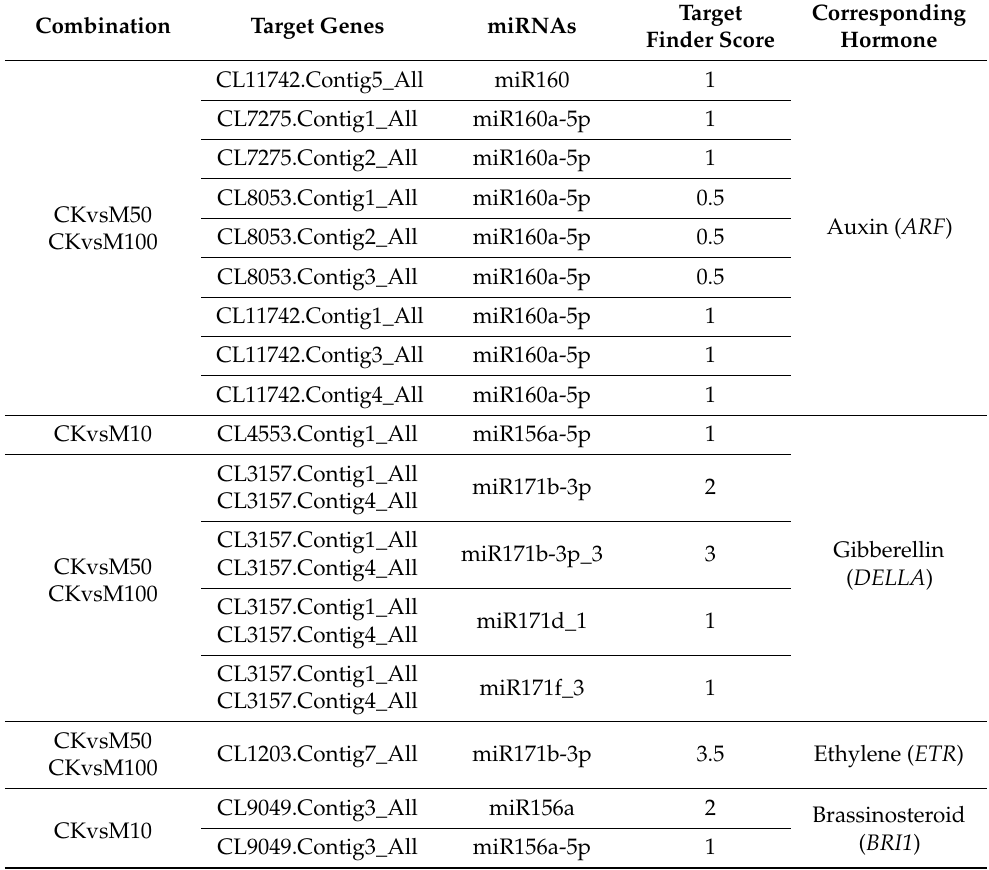
Table 1. miRNAs and target genes related to plant hormone signal transduction in rosemary suspen- sion cells. Combination Target Genes miRNAs